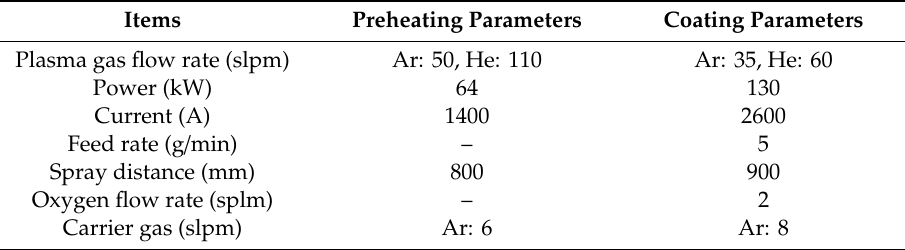
Table 1. Spray parameters for YSZ coatings by PS–PVD.